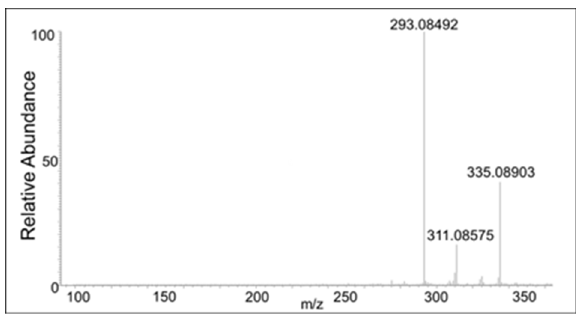
/ z 353 mass unit ion eluting at 17 min. Int. J. Mol. Sci. 2020 , 21 , 6774